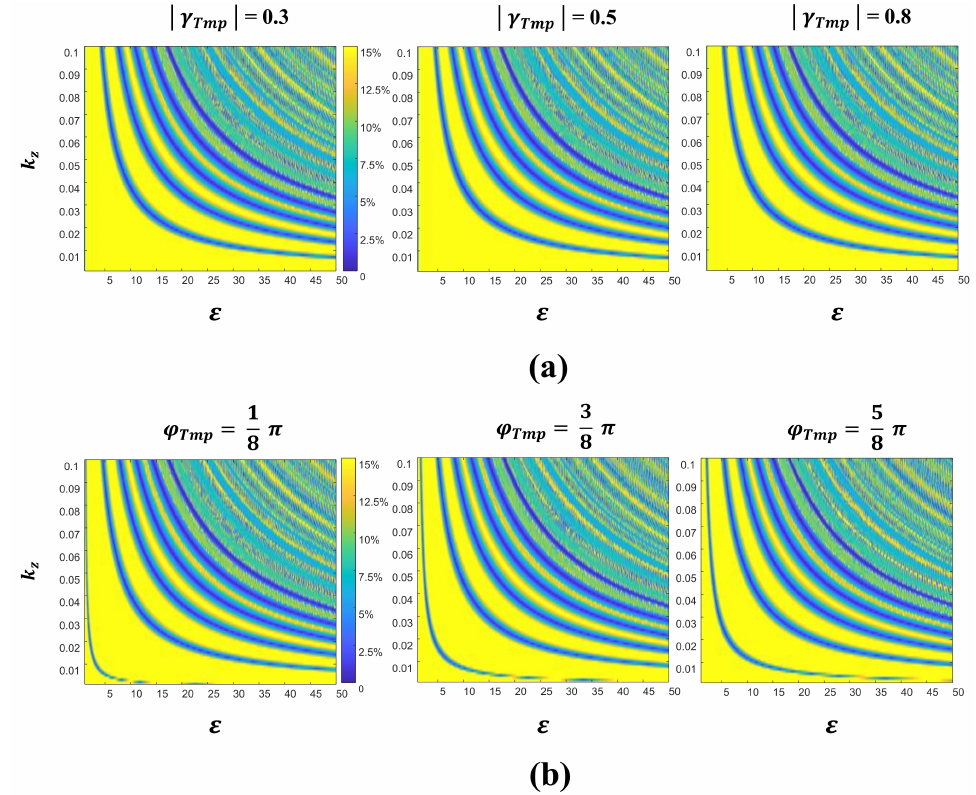
Figure 11. Distribution of relative forest height inversion errors with k z and ε for different temporal decorrelation effects. h True is set to 20 m, σ is 0.2, k z ranges from 0 to 0.1, and ε ranges from 1 to 50. ( a ) Plots of forest height errors for different γ Tmp coherence amplitudes, with phase set to 0. ( b ) Plots of forest height errors for different γ Tmp phases, with amplitude set to